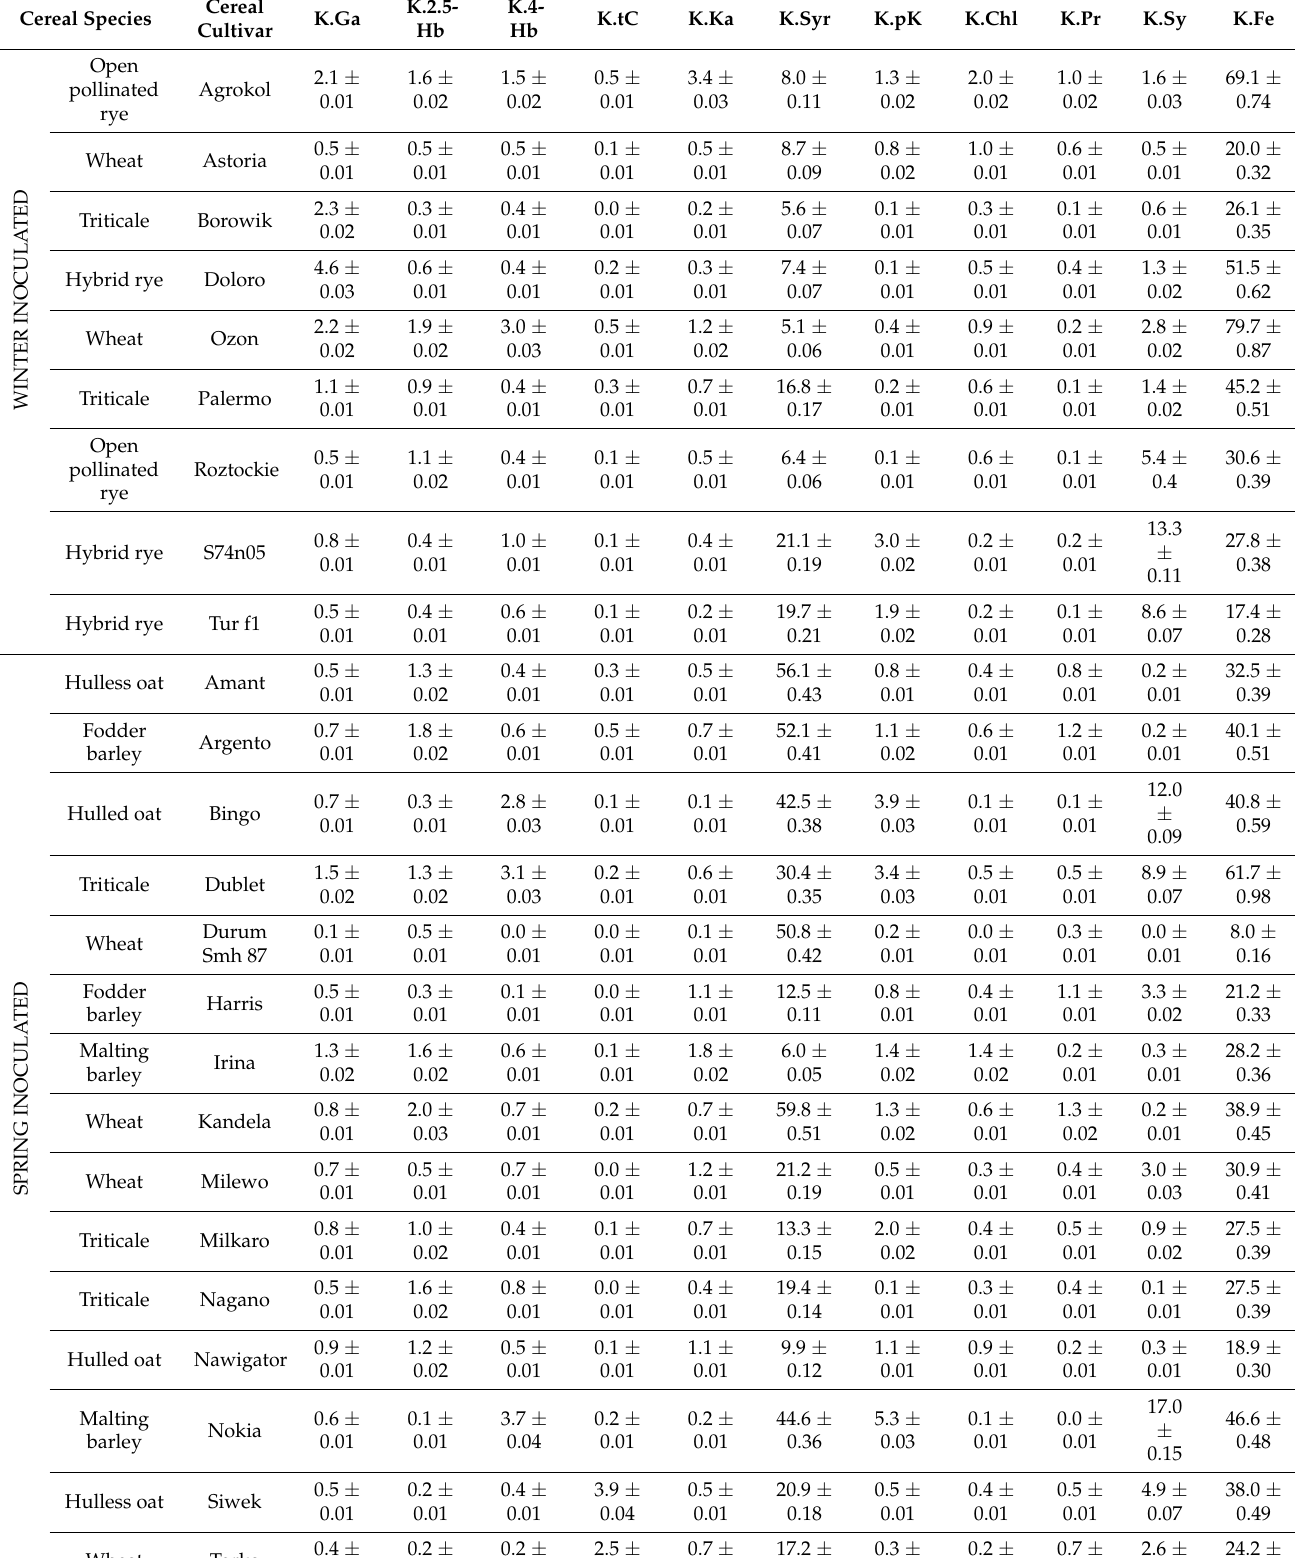
Table 5. Concentration of bee phenolic acids in extracts obtained from naturally infected cereal